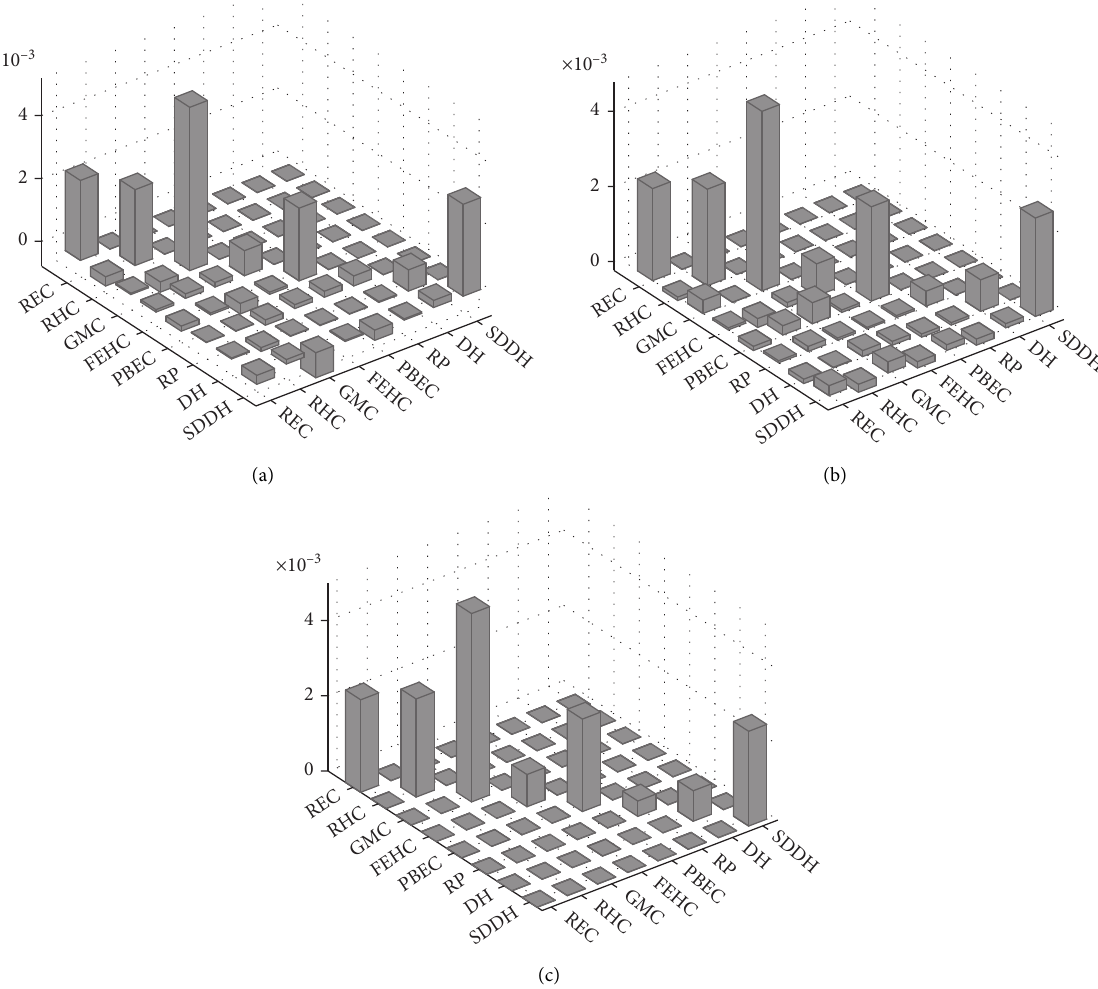
Figure 4: The relative covariance matrix generated by CUSA with the sample size of 100. (a) Generated by SRS. (b) Generated by LHS. (c) Generated by